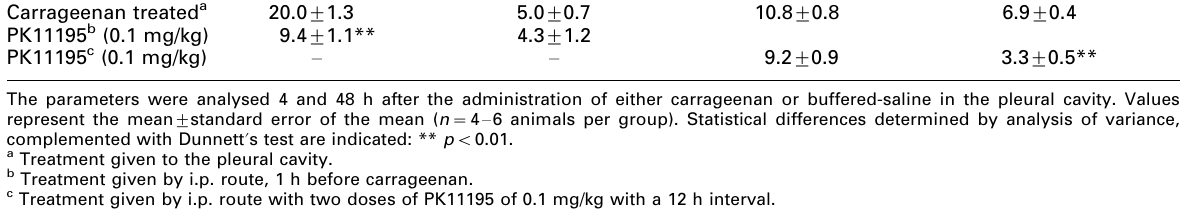
Saline treated a